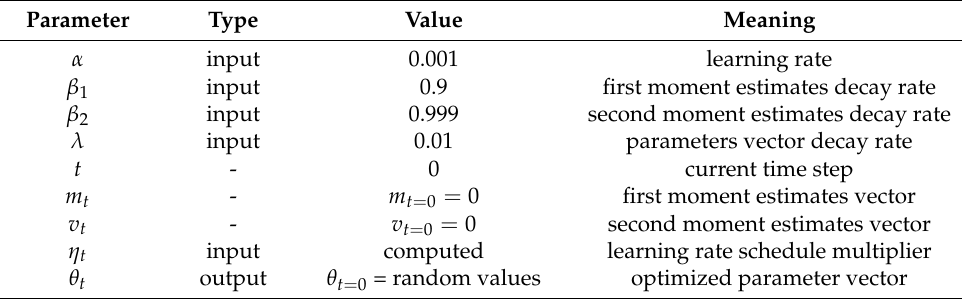
Table 1. Parameters used by Adam with L2 regularization and